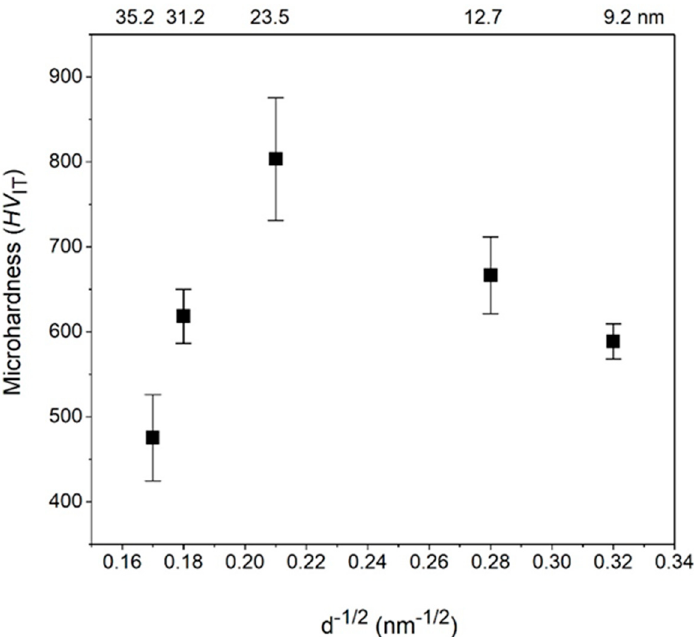
Figure 2. Hall–Petch plot of as-deposited Ni and heat-treated Ni coatings obtained in a plating bath composed of ChCl and EG (1:2 molar ratio). Mean crystallite size (in nm) is given on the top X